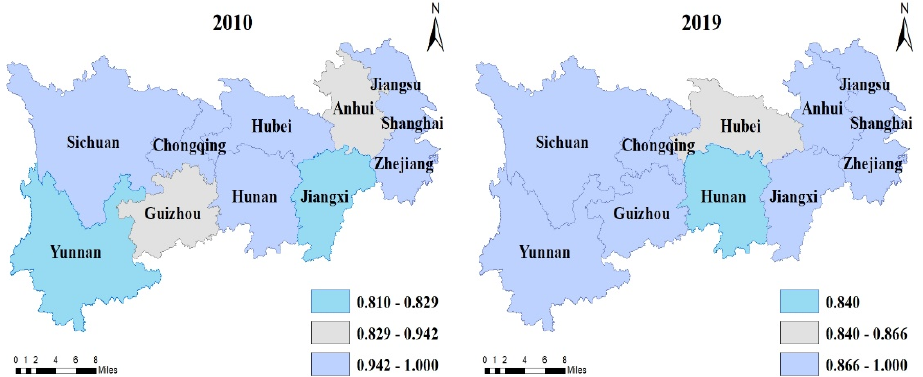
Figure 4. Same as Figure 3, but for pure technical efficiency in the YREB.